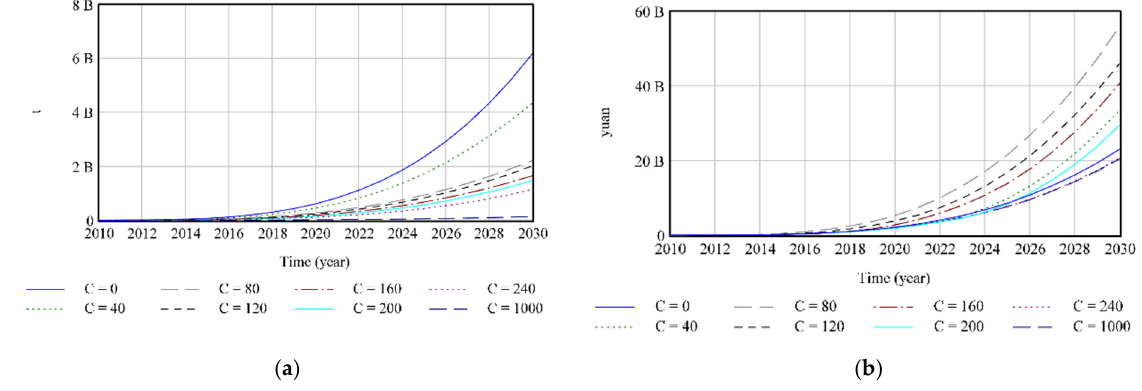
Figure 8. Impact of different charges. ( a ) Total landfill. ( b ) Environmental benefit. Table 4. The impact of different charging policies on the total amount of solid waste landfilling and environmental